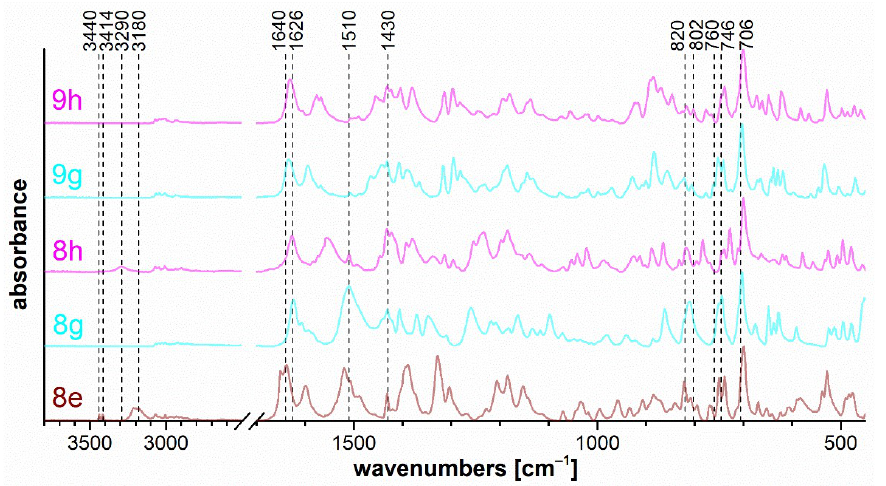
Figure 10. FTIR ATR spectra of triazaborines 8e , 8g , and 8h , and oxazaborine–triazaborines 9g and 9h